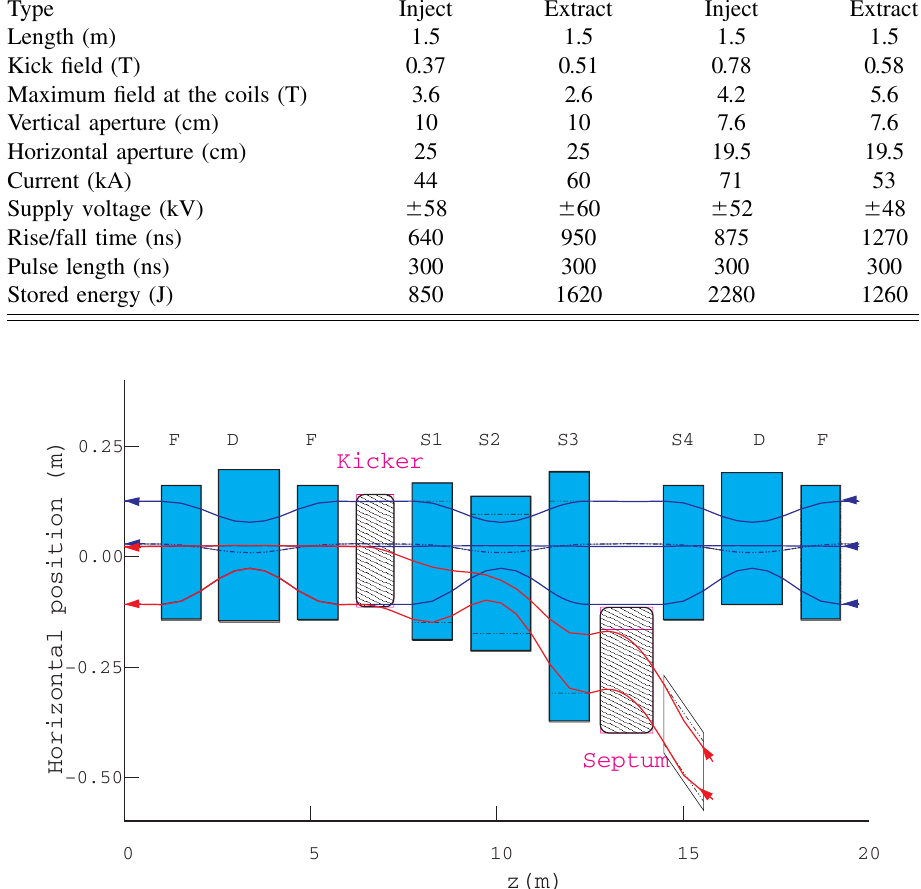
FIG. 29. (Color) Injection into the FFAG. S1 to S4 are special injection region